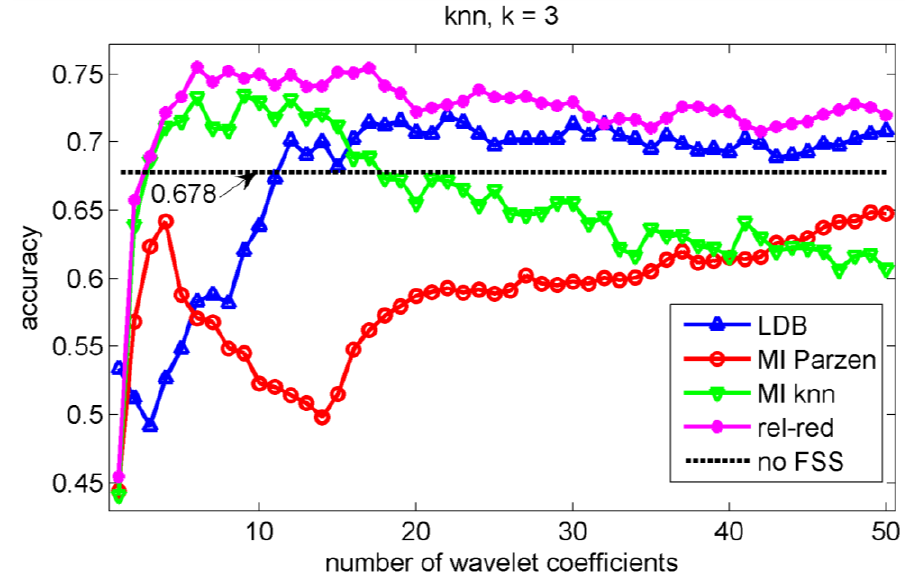
Figure 5. Evolution of the accuracy of the k-nearest neighbor classifier (k = 3) as a function of the number of wavelet coefficients selected with the LDB algorithm and the mutual information filter algorithms. The horizontal line indicates the accuracy when all 1,024 samples are used (no FSS).